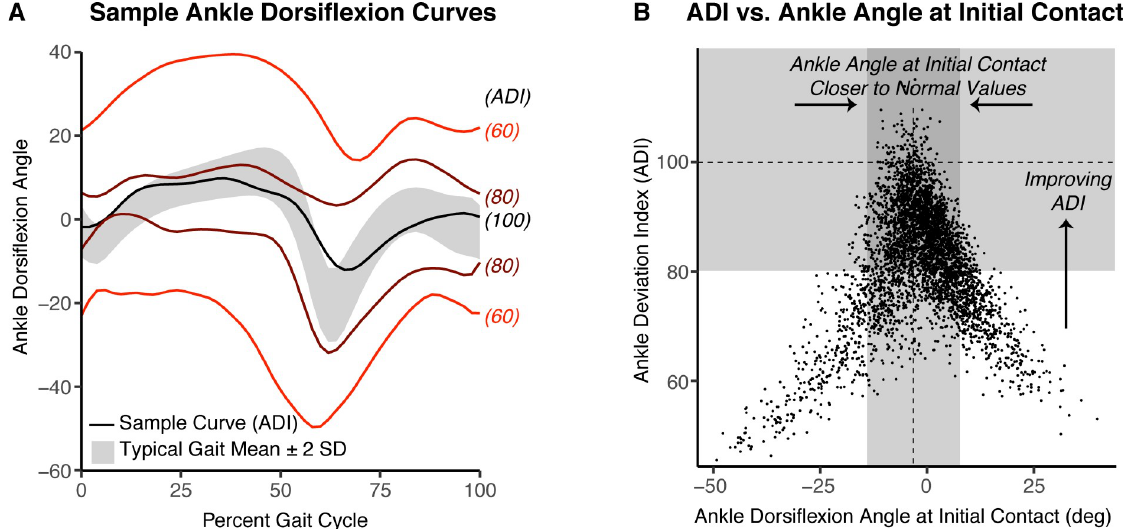
Fig 3. Ankle Deviation Index as indicator of ankle kinematics normalcy. The Ankle Deviation Index (ADI) is a summary metric that quantifies the normalcy of the ankle dorsiflexion angle time series with respect to typical gait. Typical gait has a mean ADI of 100, with every 10 point decrement representing one standard deviation away from the mean. (A) Sample kinematic trajectories and the corresponding ADI are shown. (B) Improvement in ADI is associated with improvements in key biomechanical parameters of gait, including ankle dorsiflexion angle at initial contact (pictured), mean stance dorsiflexion angle, peak dorsiflexion angle in swing, and others. Each point represents an observation used in the development of the ADI.